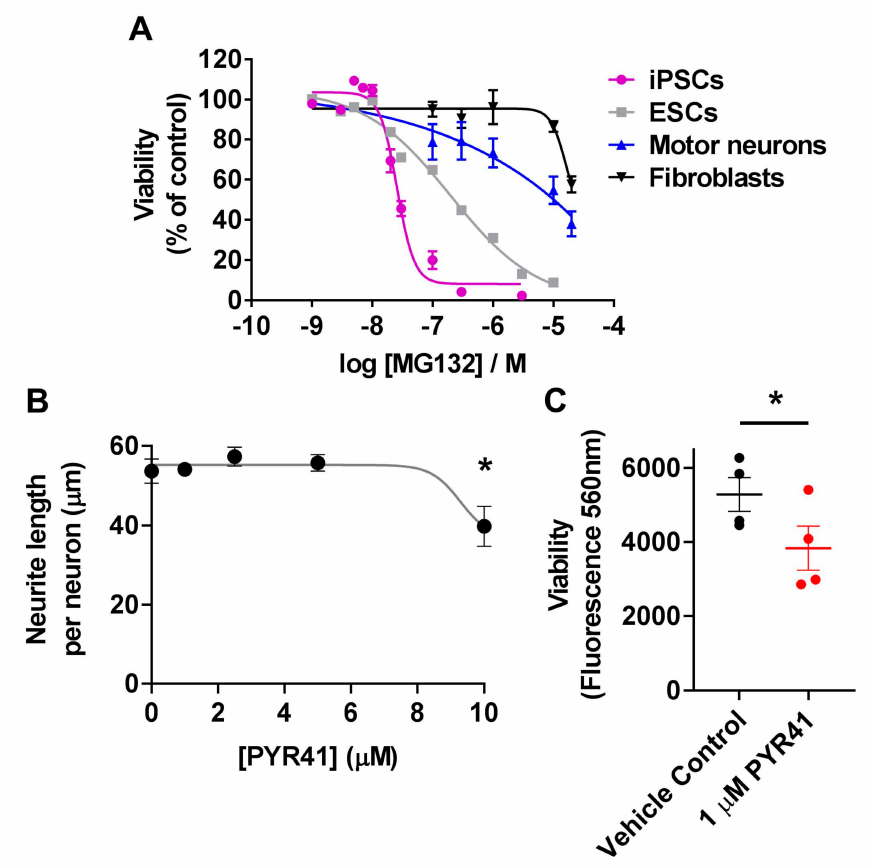
Figure 4. Di ff erential sensitivity of various cell states to UPS inhibition. ( A ) Viability of iPSCs, ESCs, motor neurons and fibroblasts following 16 h treatment with increasing doses of the proteasome inhibitor MG132. ( B ) Neurite outgrowth of motor neuron precursors following 24 h treatment with 1 µ M–10 µ M UBA1 inhibitor (PYR41). ( C ) Viability of motor neurons subjected to long-term (4 week) treatment with 1 µ M PYR41 UBA1 inhibitor (red) or vehicle control (black). Data shown are mean ± SEM, n = 3–4, * p < 0.05 (one-way ANOVA Brown-Forsythe test ( B ), or two-tailed paired t-test ( C